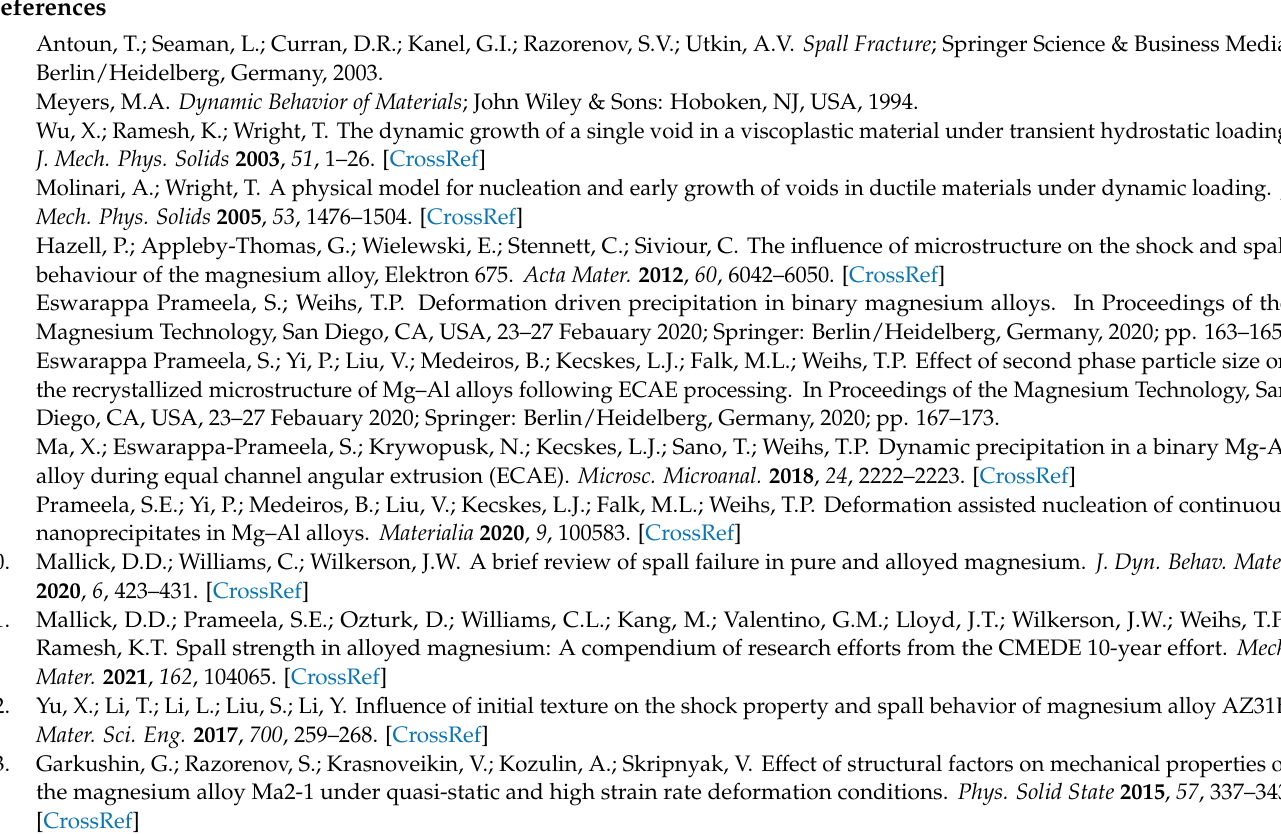
Figure A5. High-resolution SEM failure surface images of representative specimens from all ECAE- processed sample sets. Each column depicts a single sample set: (left) 9A STEP, (center-left) 6A ISO, (center-right) 9A ISO, and (right) 6A STEP. Micrographs are shown from ( A – D ) secondary electrons (SE), ( a – d ) backscattered electrons (BSE), and ( a’ – d’ ) magnified BSE. Frame ( A ) shows the scale bar for ( A – D ) and ( a – d ), and Frame ( a’ ) shows the scale bar for ( a’ – d’